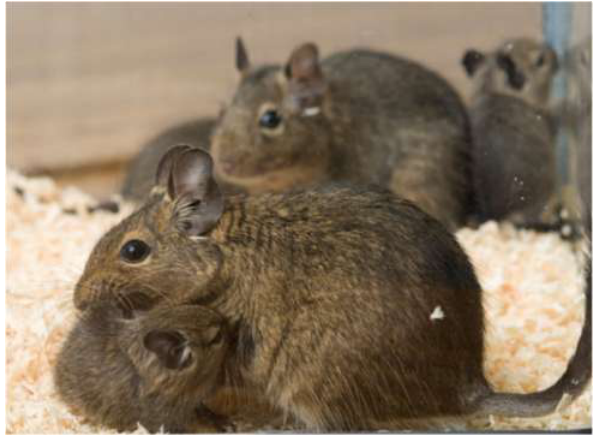
Figure 1. A degu family. Mother and her pup (front) and father with siblings (back).